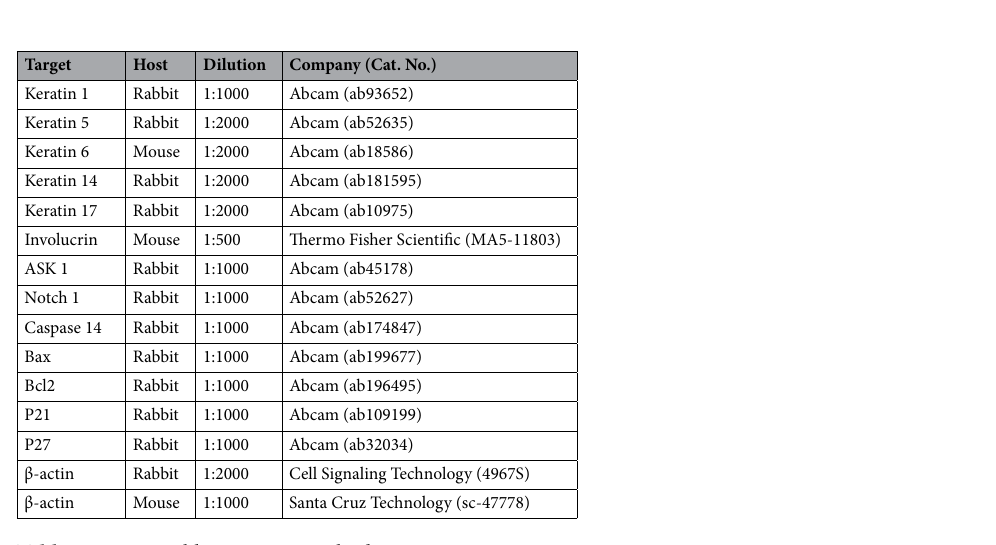
Table 2. Western blot primary